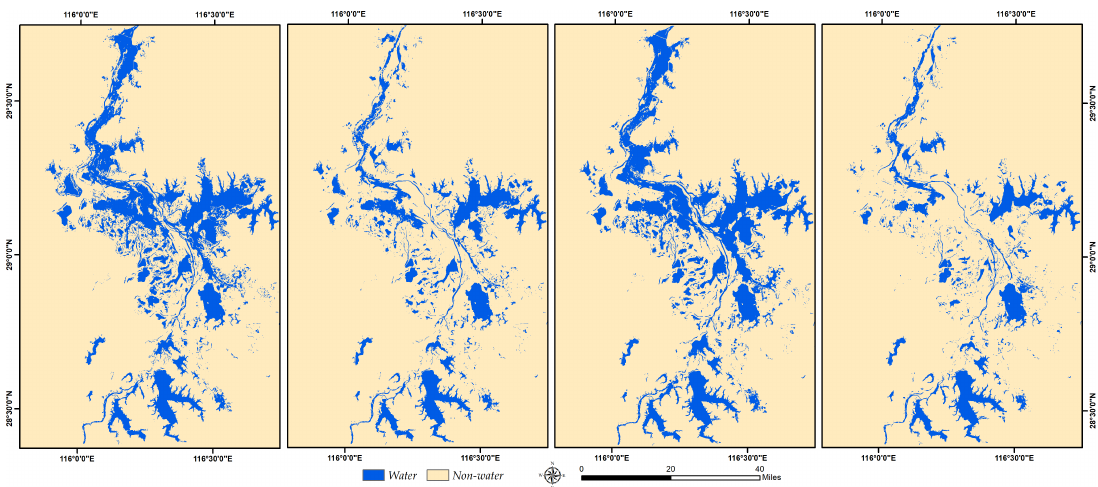
Figure 4. Inundation Area of Poyang lake in Winter of 2017, 2018, 2019 and 2020 (from left to